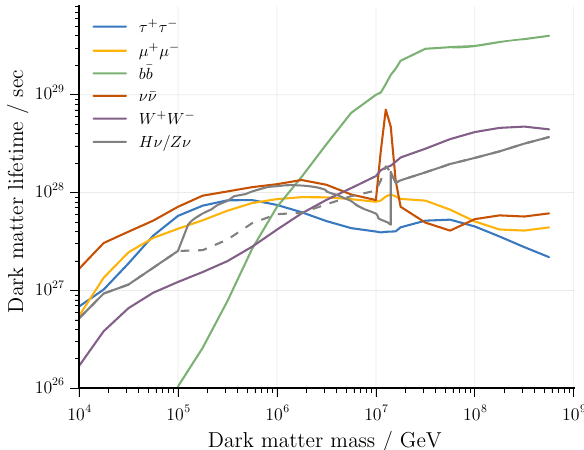
Fig. 8 Comparison of the lower lifetime limits with results obtained from gamma-ray telescopes: HAWC (Dwarf Spheroidal Galaxies) [44], HAWC (Galactic Halo/Center) [45] and Fermi/LAT